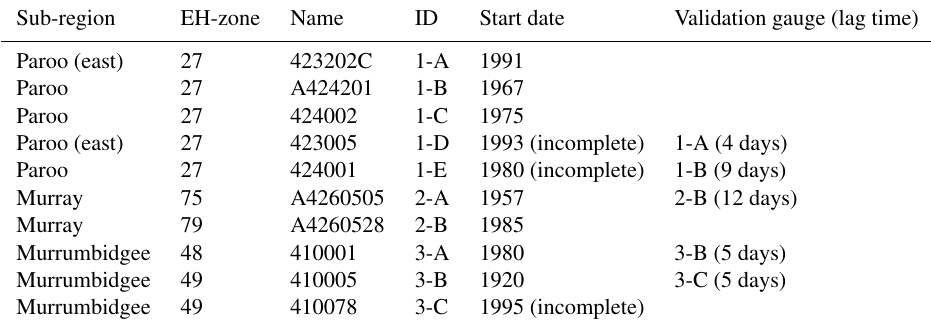
Table 5. Official names, ID, and start dates of river gauges and data used for this analysis along with estimated average flow travel times between gauges used for validation of Q